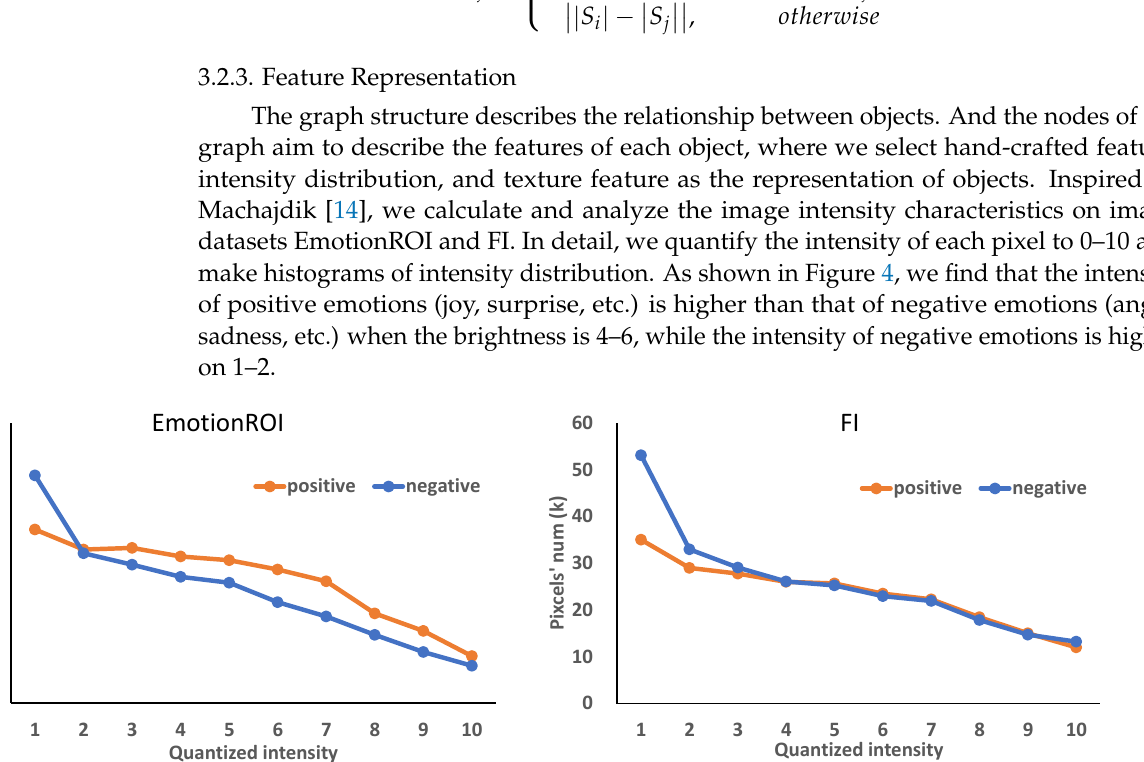
Figure 4. The distribution curve of the number of brightness pixels of different emotion categories in the EmotionROI and Flickr and Instagram (FI)